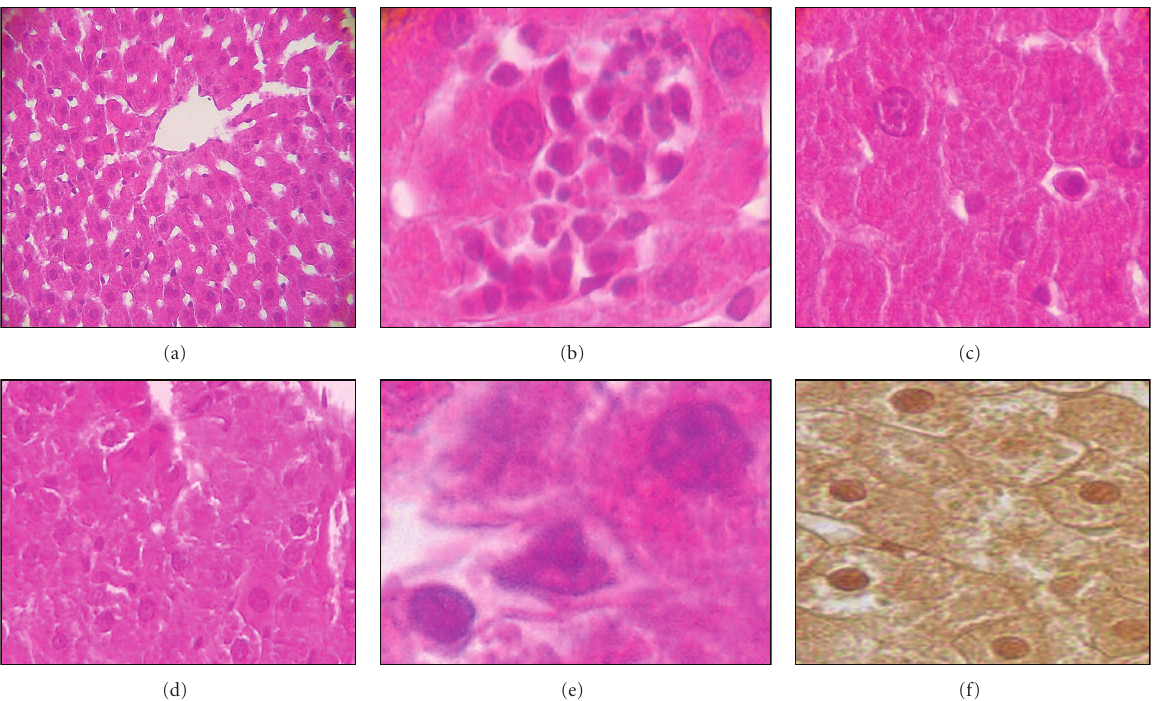
Figure 4: Histological lesions in the liver of rats exposed to lead and treated with glycine 100 mg/kg for 5 days. (a) Classic liver lobule, sinusoids, portal triads, and portal vein diameter were normal (H&E stain × 20). (b) Inflammatory cell infiltration (H&E stain × 64). (c) Irregular membrane cell (H&E stain × 64). (d) Necrosis (H&E stain × 64). (e) Nucleus irregular in shape (H&E stain × 64). (f) Apoptosis (TUNEL stain × 20). Table 1: Lead concentration in the blood ( μ g/dL), brain, liver, kidney, and bone ( μ g/g) of rats. Lead was given in drinking water for 5 weeks, after which, the lead was withdrawn and the rats (1) received plain water for 5 days or (2) received plain water for 28 days. Control groups Blood Brain Liver Kidney Bone Negative control 0.65 ± 0.23 0.21 ± 0.05 0.50 ± 0.17 0.20 ± 0.05 1.1 ± 0.3 Positive lead control 1 39 . 2 ± 5 . 1 a Positive lead control 2 24 . 3 ± 3 . 6